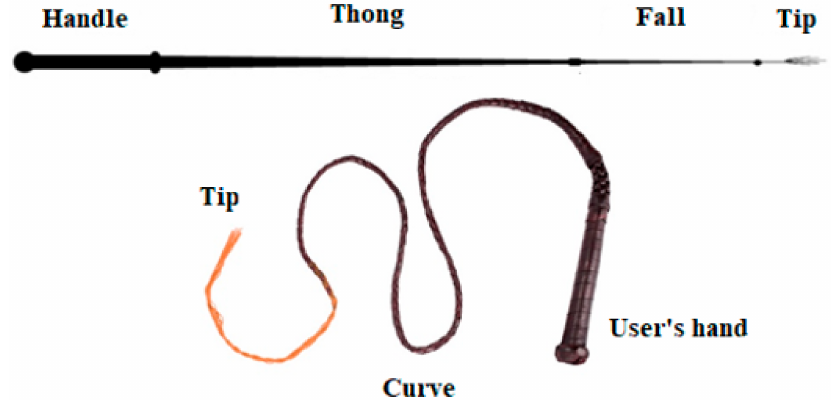
Figure 4. Basic elements of a